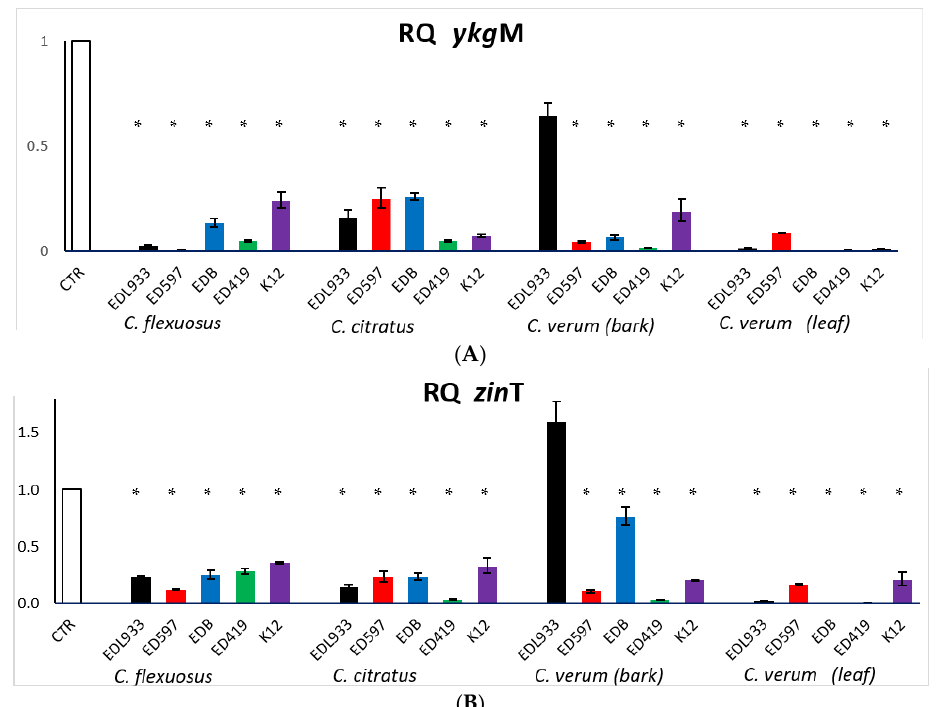
Figure 3. Transcriptional profiles of ykg M ( A ) and zin T ( B ) in E. coli cells treated with or without EOs (CTR), obtained by qRT-PCR. Relative gene expressions represent transcriptional levels after exposure to EOs versus untreated controls. The experiment was performed three times. * p < 0.01.